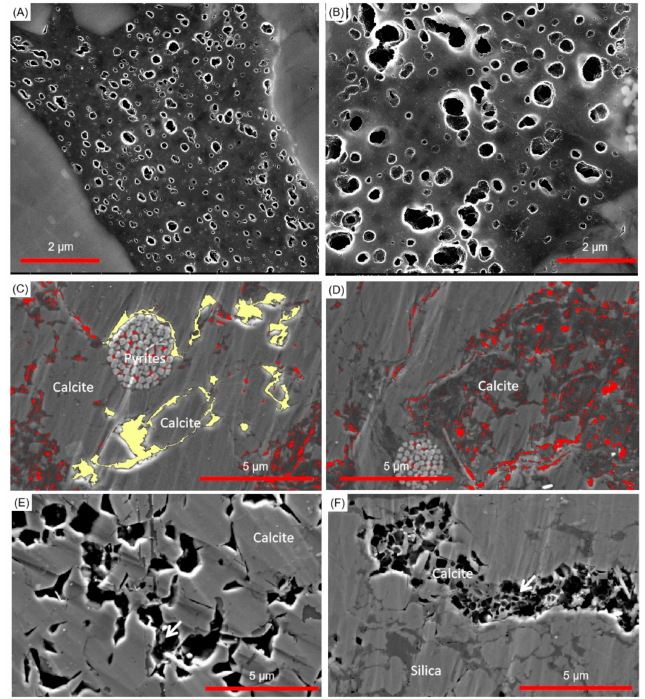
Figure 11. Backscattered electron images showing nanopores in shale with various depositional structures from Shuanghe outcrop in Changning County. Organic pores are round, elliptical, or elongated, and inorganic pores are intergranular dissolved pores, irregular, or harbor-like. ( A ) Organic pores, sample number is 8-4-1; ( B ) Organic pores, sample number is 8-10-2; ( C ) Or- ganic pores and inorganic pores. Sample number: 9-16-2; ( D ) Organic pores. Sample number: 10-14-1; ( E ) Inter-particle dissolved pores, sample number is 4-28-1; ( F ) Inter-particle dissolved pores, sample number is 9-16-2. Note that the red color denotes organic pores, the yellow color represents inorganic pores and the lilac color represents microfractures.